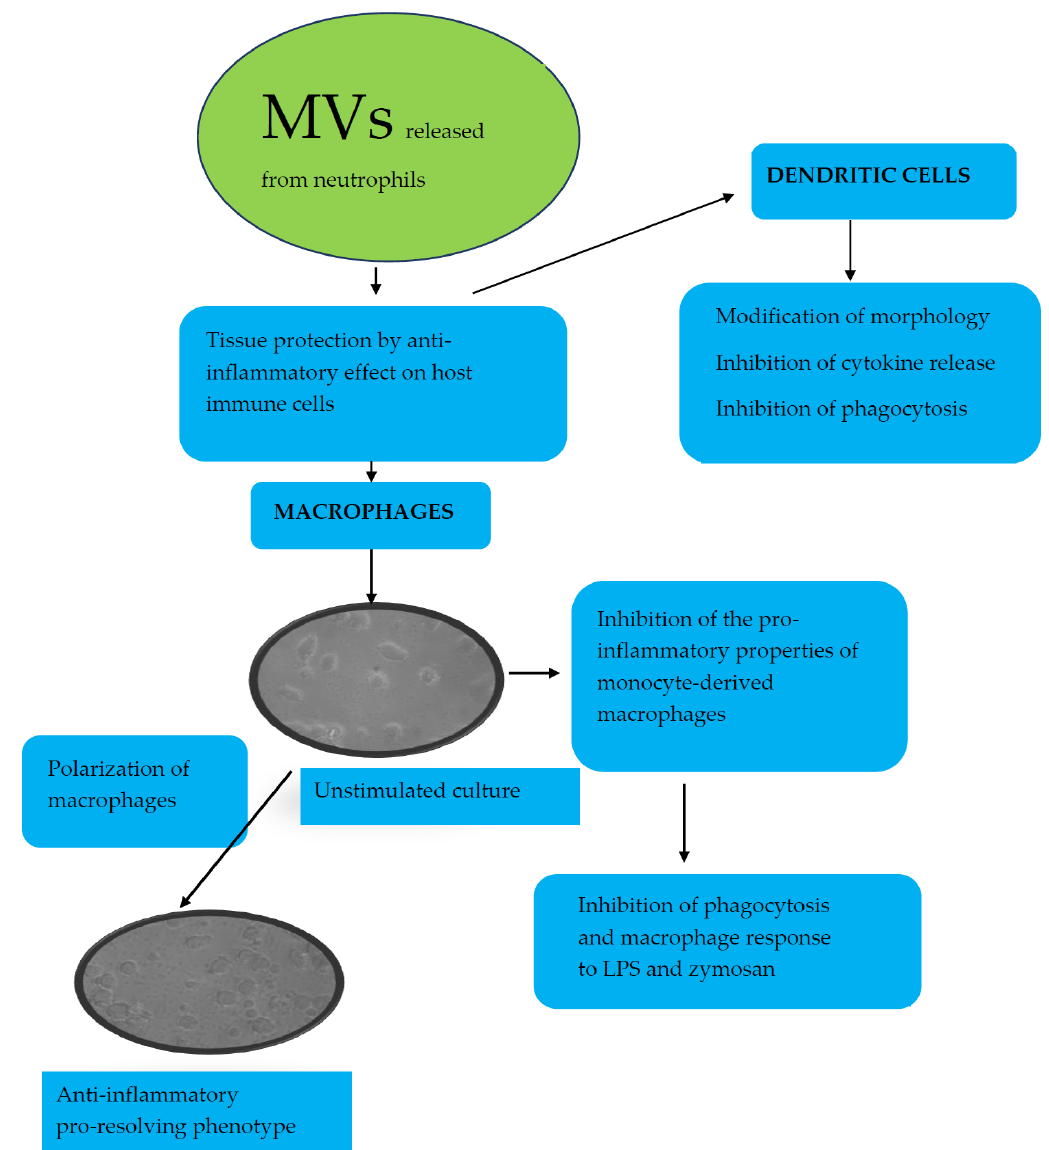
Figure 2. Different effects of neutrophil-derived MVs on host cells, especially on monocyte-derived macrophages and dendric cells.